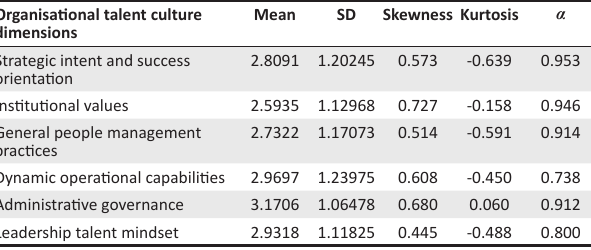
TABLE 2: Descriptive statistics of the organisational talent culture questionnaire. Organisational talent culture dimensions Strategic intent and success orientation